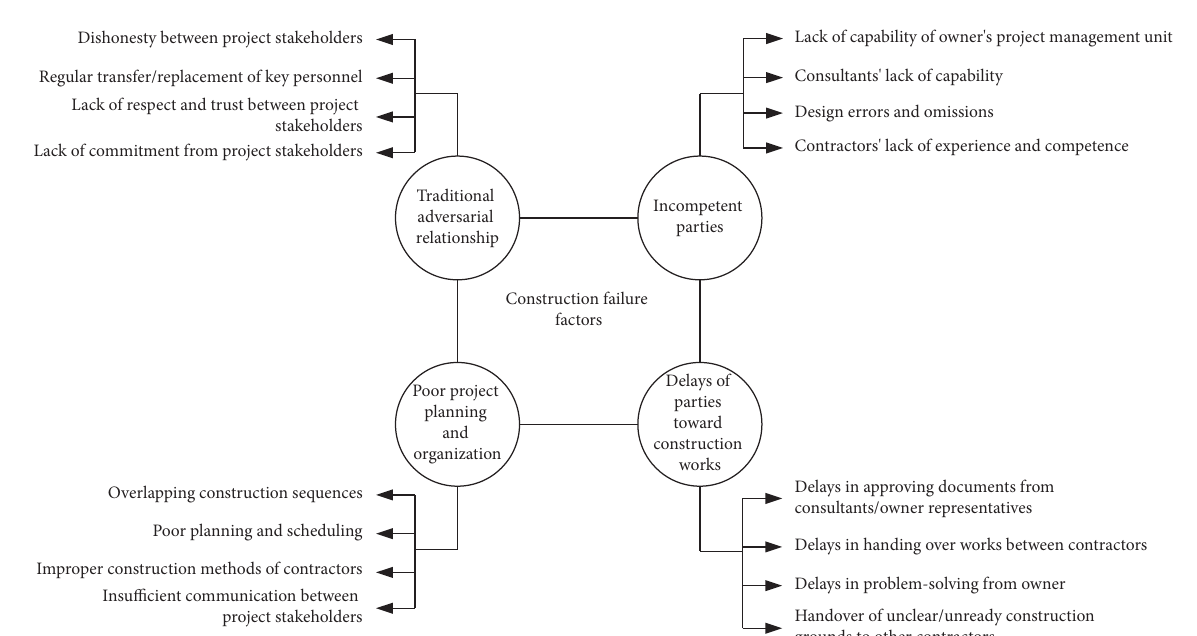
Figure 3: The main factors of construction failure factors to stakeholder coordinating performance in the finishing phase of high-rise building